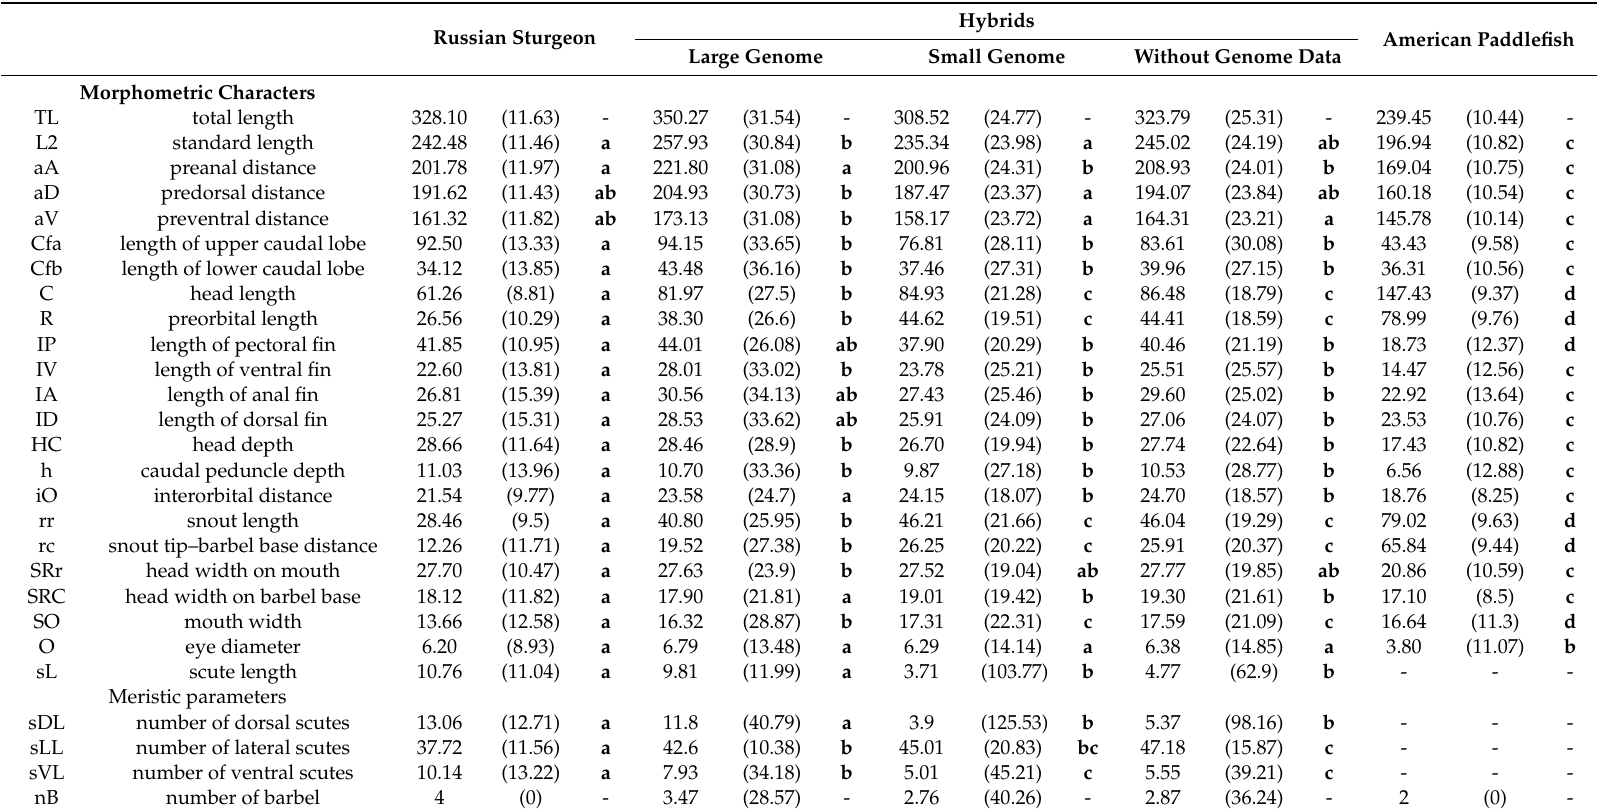
Table 3. Mean morphometric (mm) and meristic characteristics among Russian sturgeon and American paddlefish and their hybrids. The numbers in parentheses are the coe ffi cient of variation percentage values. The hybrids were grouped by genome size into small genome hybrids, large genome hybrids, and hybrids without genome size data. Di ff erent bold letters (a, b, c, d) indicate the significant di ff erences ( p > 0.05) based on Kruskal–Wallis tests and Mann–Whitney U pairwise comparisons on standardized data. The data were standardized on the total length; hence, this character was not available for pairwise